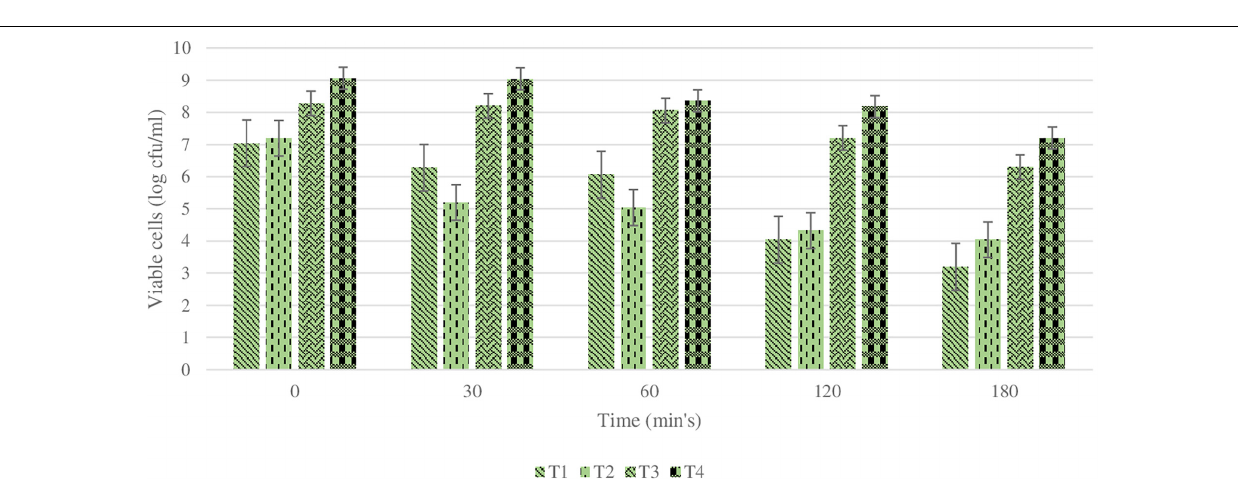
FIGURE 5 | Changes in viability (cell count) of plain or coated L. rhamnosus cells after exposure to simulated intestinal fluids for 30, 60, 120, and 180 min. Tl : plain L. rhamnosus, T2: coated cells with BSP/Glucomannan, T3: coated cells with BSP/Alginate and T4:coated cells with